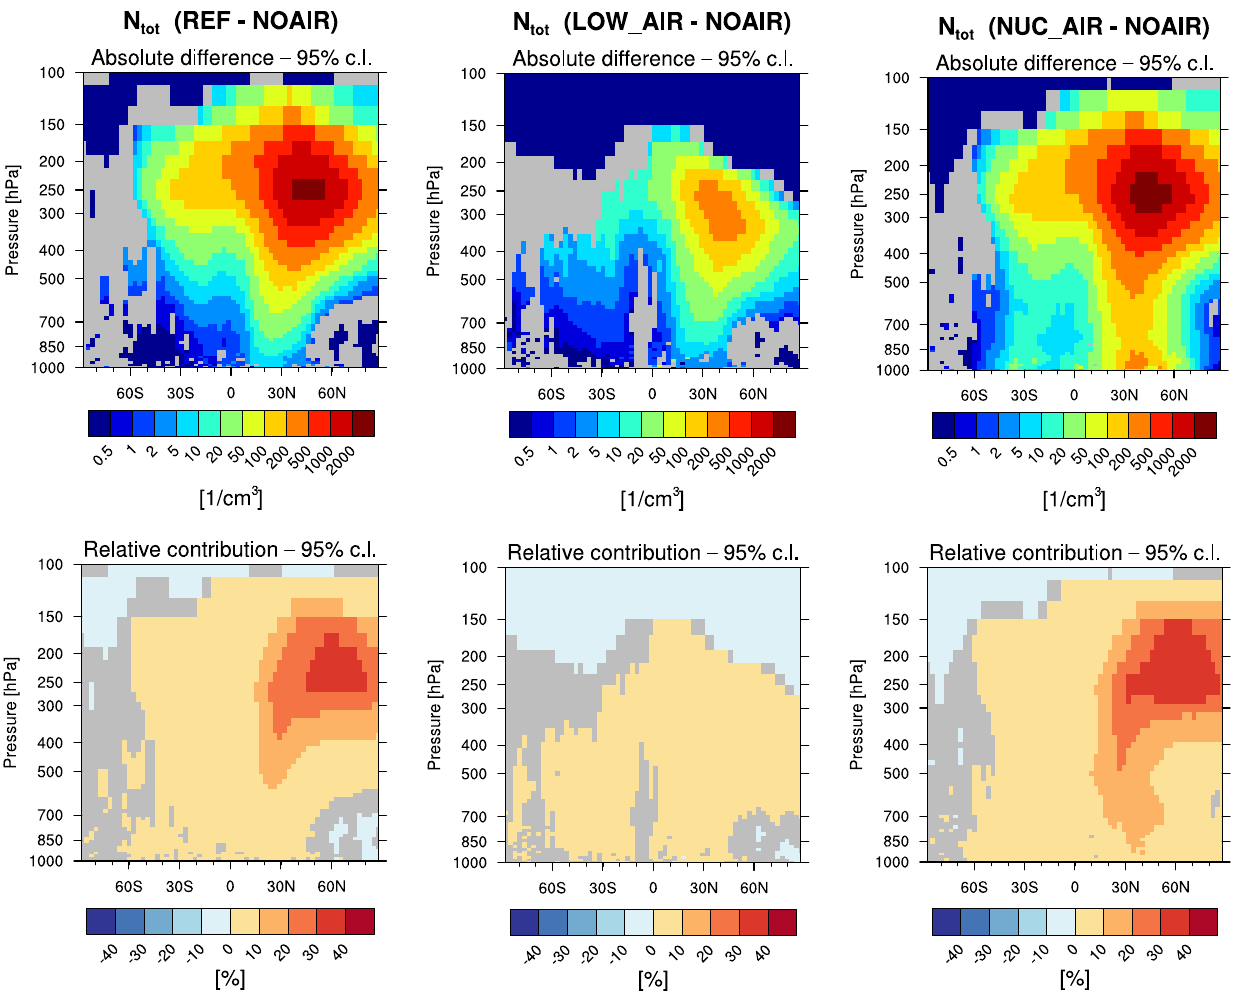
Fig. 11. Multi-year average (1996–2005) zonal means of the absolute (top) and the relative effect (bottom) of aviation on the Aitken and accumulation mode number concentration. Plotted are the differences between the experiments HIGH_AIR (REF) and NOAIR (left), between LOW_AIR and NOAIR (middle) and between NUC_AIR and NOAIR (right). The relative effect is calculated as the relative contribution (REF–NOAIR)/REF (left), (LOW_AIR–NOAIR)/LOW_AIR (middle) and (NUC_AIR–NOAIR)/NUC_AIR (right). Grid points where the difference is not statistically significant according to a uni-variate t test (5% error probability) are masked out in